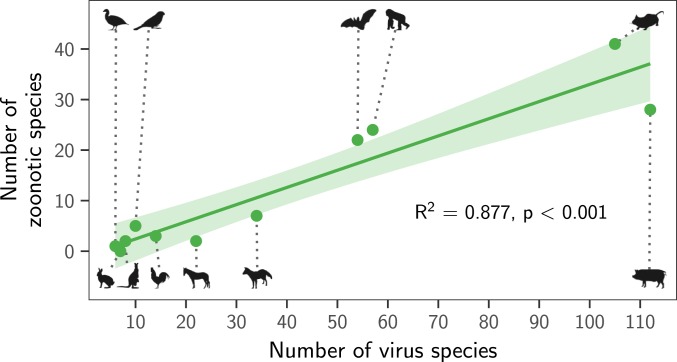
Relationship between the number of virus species and the number of zoonotic species maintained by each reservoir group. The line shows a linear regression fit, with its 95% CI indicated by the shading.